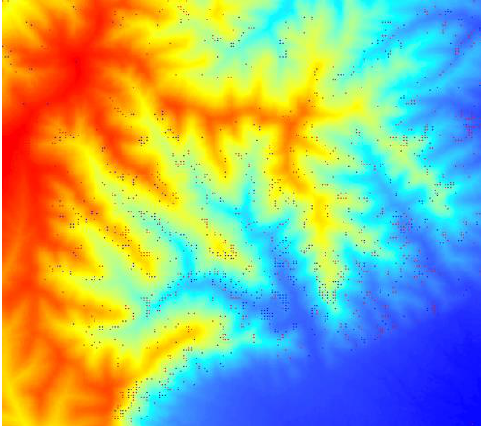
Figure 3. The checking points with residuals larger than 10- meter distribution in 5-meter grid DSM automatically generated with Forward-Nadir-Backward stereo views images